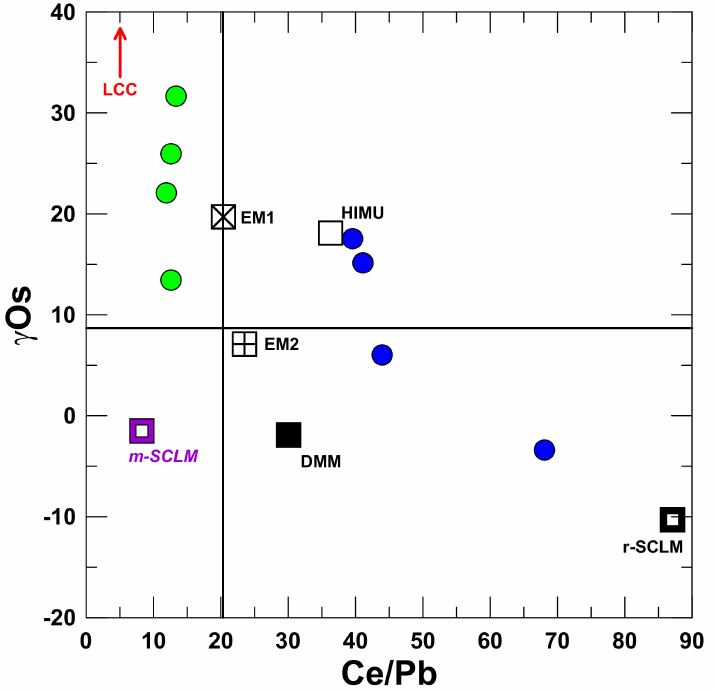
Figure 18. Ce/Pb versus γ Os values of Christmas Island lava series. Data sources as follows: horizontal and vertical lines represent average Indian N-MORB [(La/Sm) N <1.0]-Ce/Pb value of 20.33 (average of n = 108) calculated from the dataset of [55], γ Os value of 8.68 is from [187]; γ Os values for DMM, EM1, EM2 and HIMU are from [32]; m-SCLM—Ce/Pb value of 8.27 is the average for Western Australian lamproites [73], γ Os value = − 1.5 [35,43]; r-SCLM—refractory sub continental lithospheric mantle—Ce/Pb value of 87.1 based on the modelling of [156], γ Os value = –10.3 [35]; red arrow points to LCC γ Os values of >250 [32,187] and Ce/Pb values of ~5 [188]. Symbols as for the figure caption to Figure